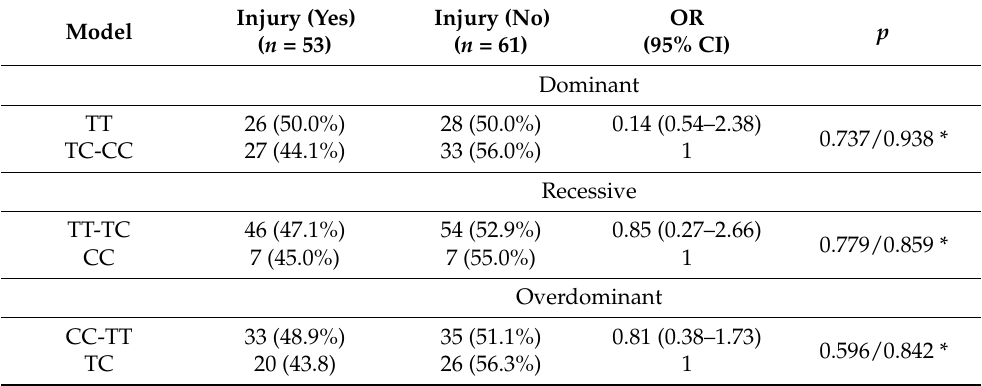
Table 4. Association of the rs13946 COL5A1 polymorphism with injury status.